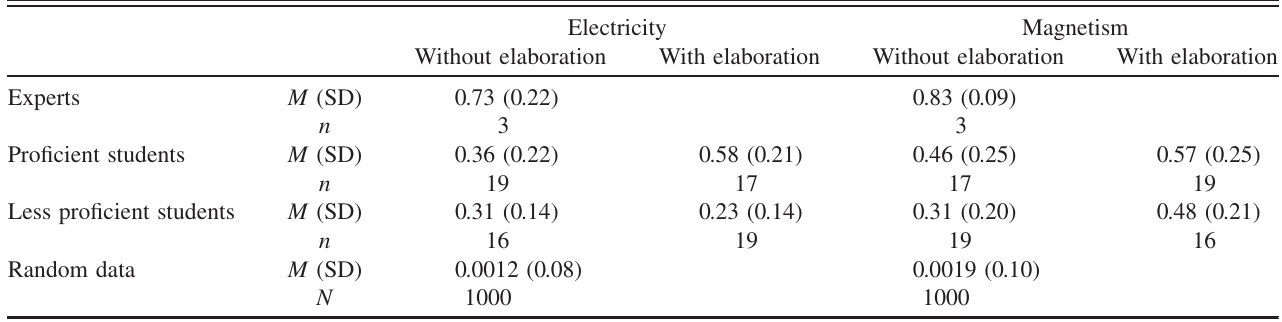
CHOOSING THE RIGHT SOLUTION . . TABLE VII. Means and standard deviations of the expert-likeness score per experimental group for real data and for computer- generated random data.